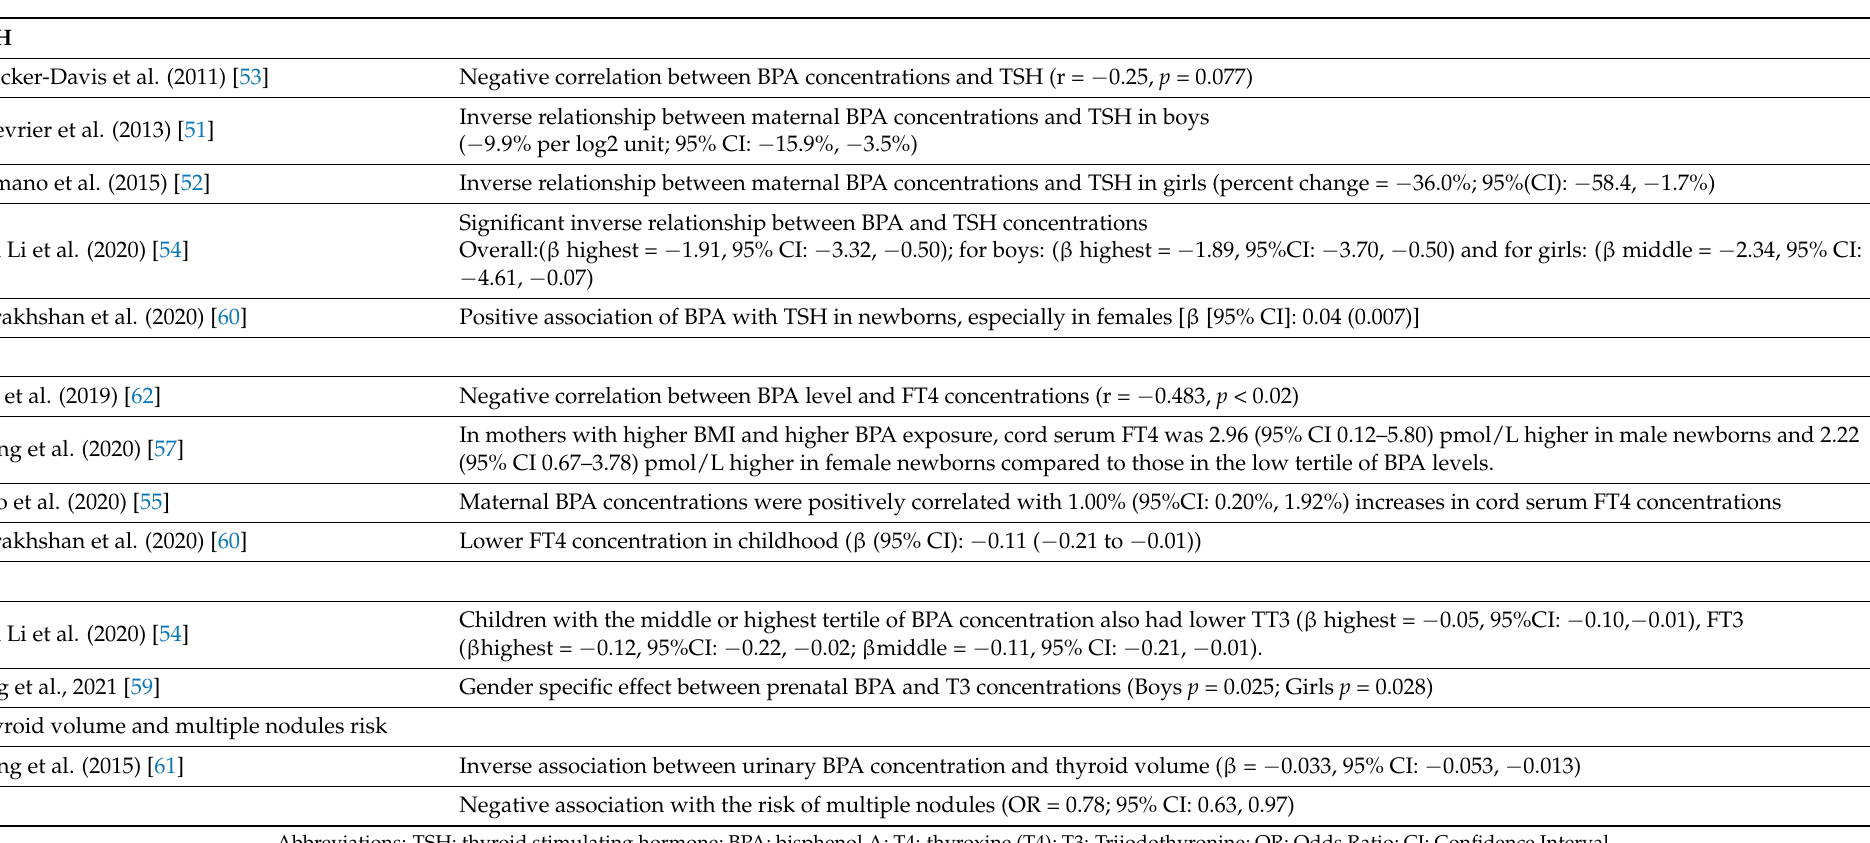
Table 4. Statistically significant correlations (r), odds ratios (OR), or logistic regression models (betas) of the association of BPA with TSH, T4, and